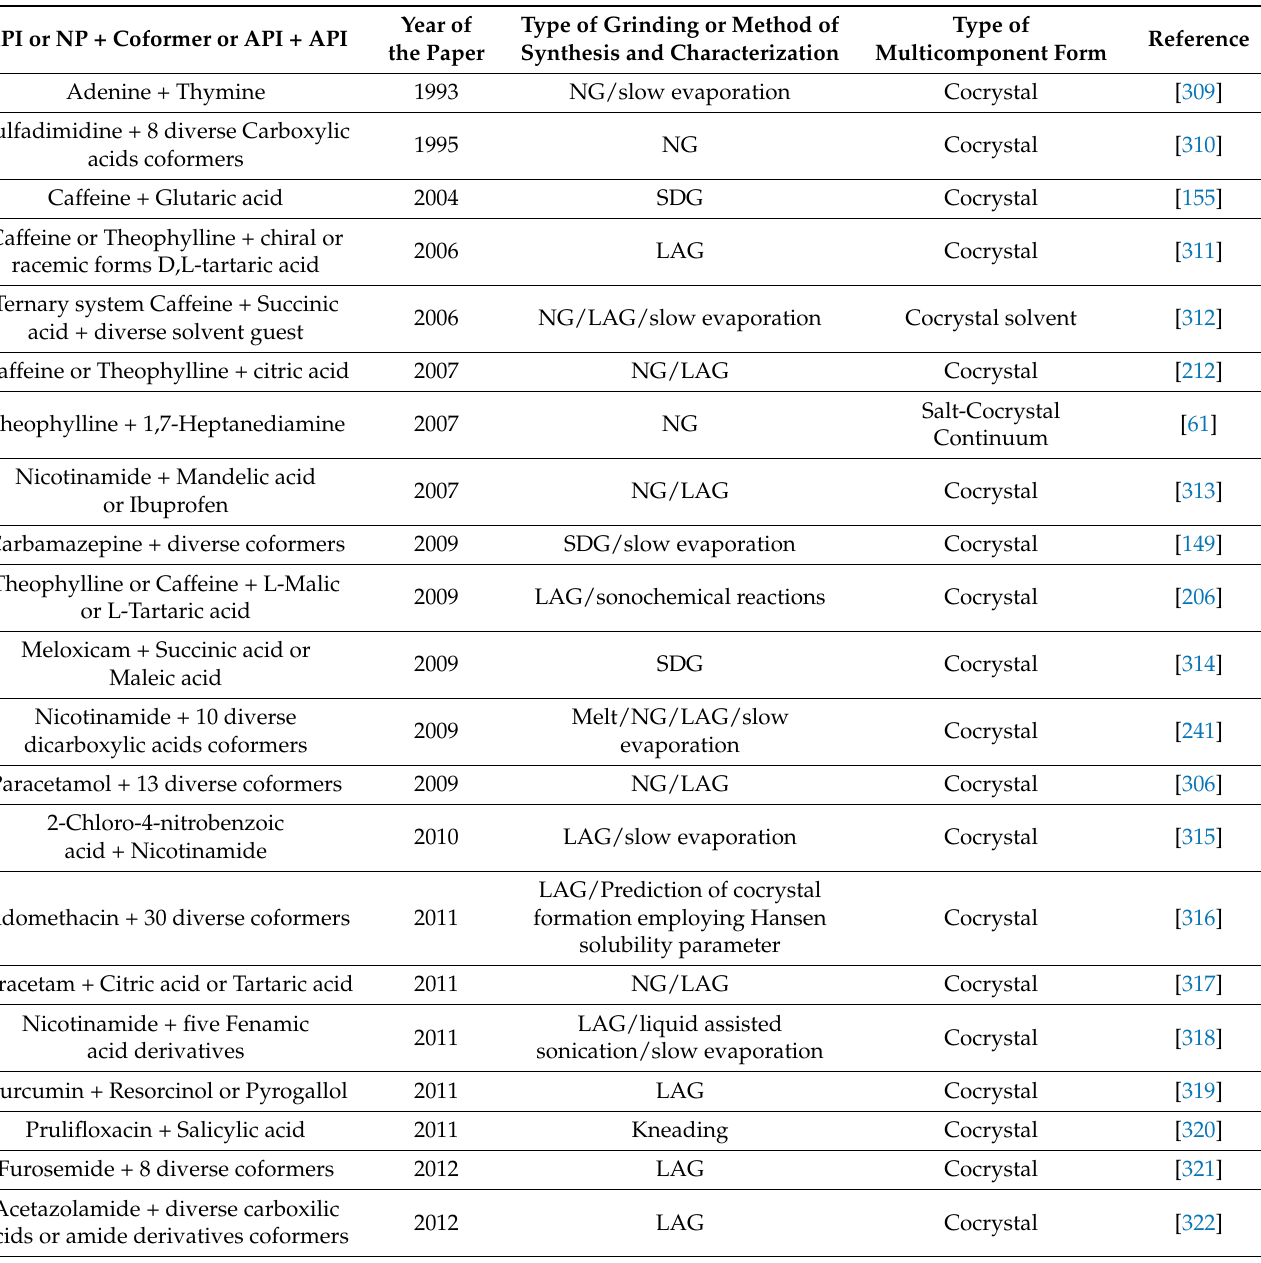
Table 1. Chronological summary of the most representative publications related with the formation of pharmaceutical cocrystals or multicomponent salts by mechanochemical